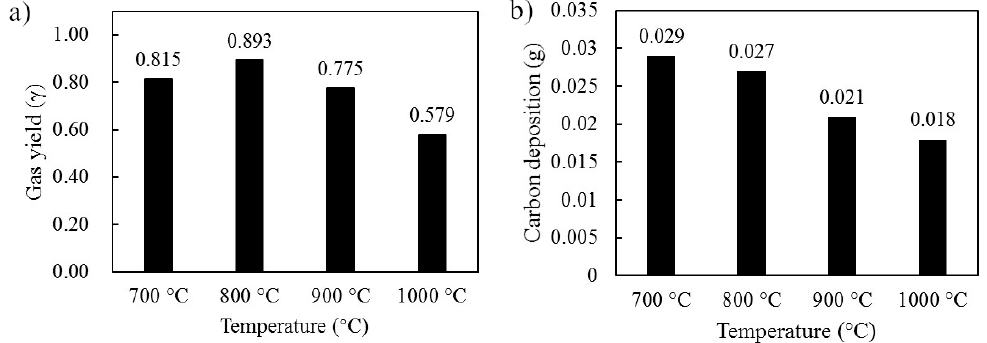
Figure 6. ( a ) The CO 2 yield ( γ CO2 ) as a function of temperature for the fifth reaction cycle and ( b ) the average amount of carbon deposition as a function of temperature for the five cycles.